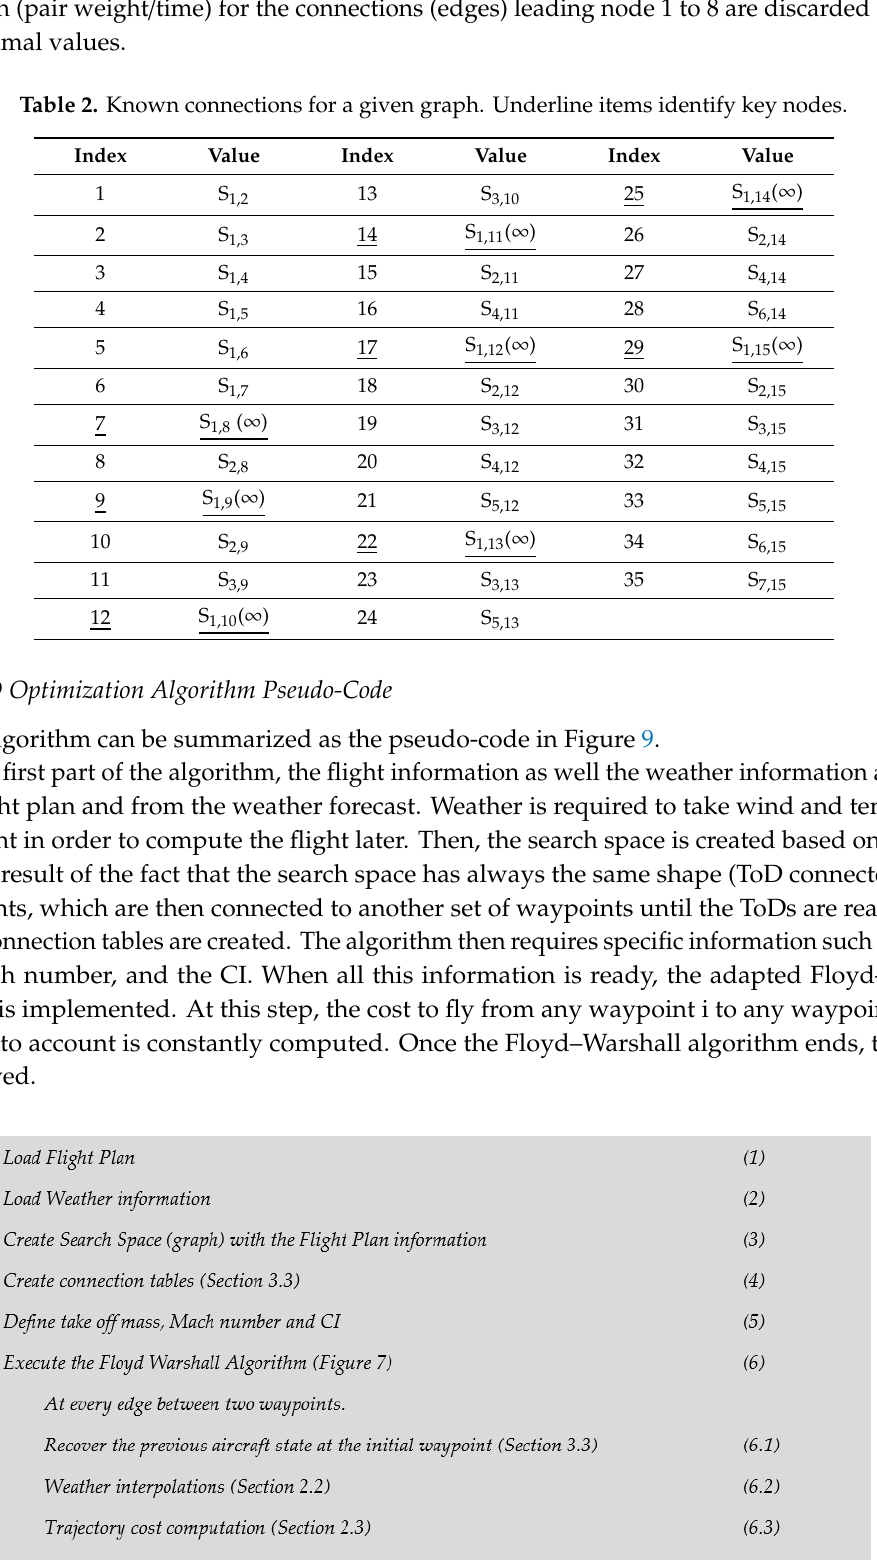
( b ) Figure 10. Lateral and vertical reference trajectory for the Flight between Montreal and Rio de Janeiro. ( a ) Lateral reference trajectory. ( b ) Vertical reference trajectory. 0